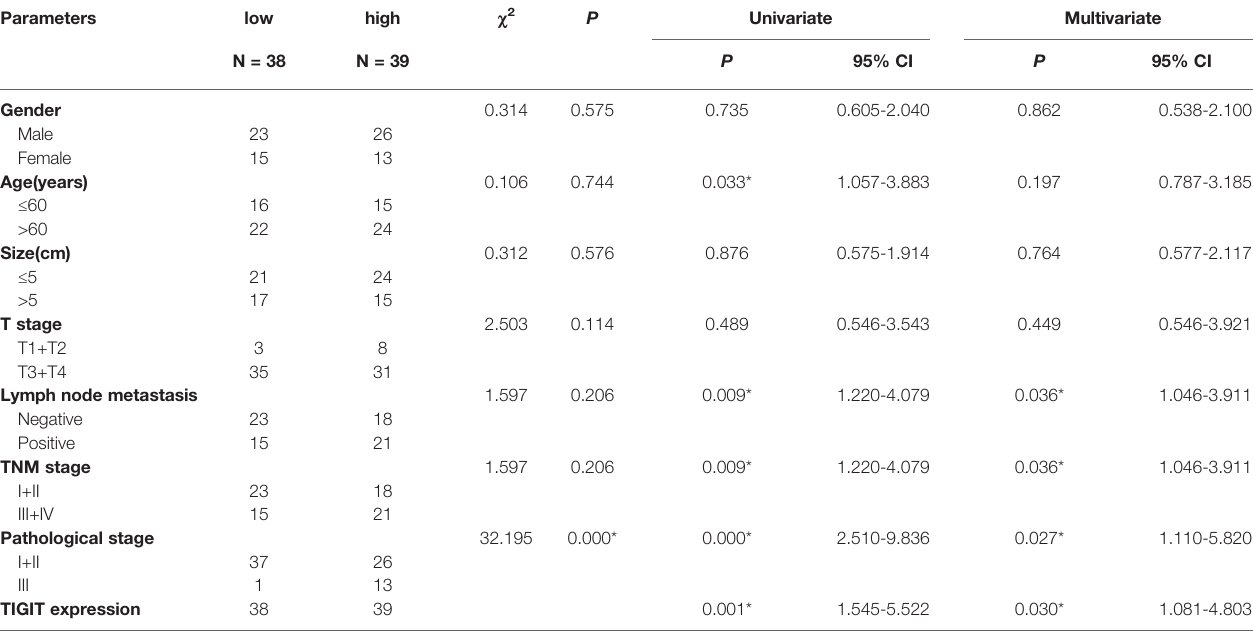
TABLE 1 | Univariate and multivariate statistics of the prognostic value of clinic pathological parameters and TIGIT expression level for survival in colorectal cancer. Parameters low high c 2 P Univariate